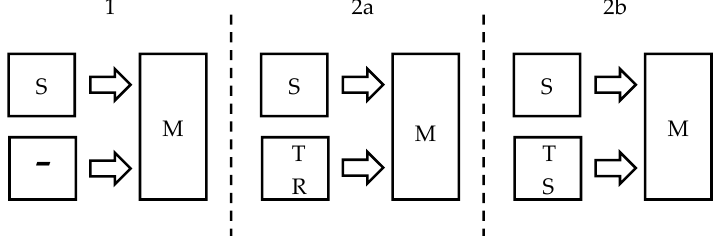
Figure 3. Modes of operation. 1: cell mode; 2a: table mode, single curve polarization table; 2b: table mode, multi curve polarization table; S: state variable; T: polarization table; R: polarization table reference values.